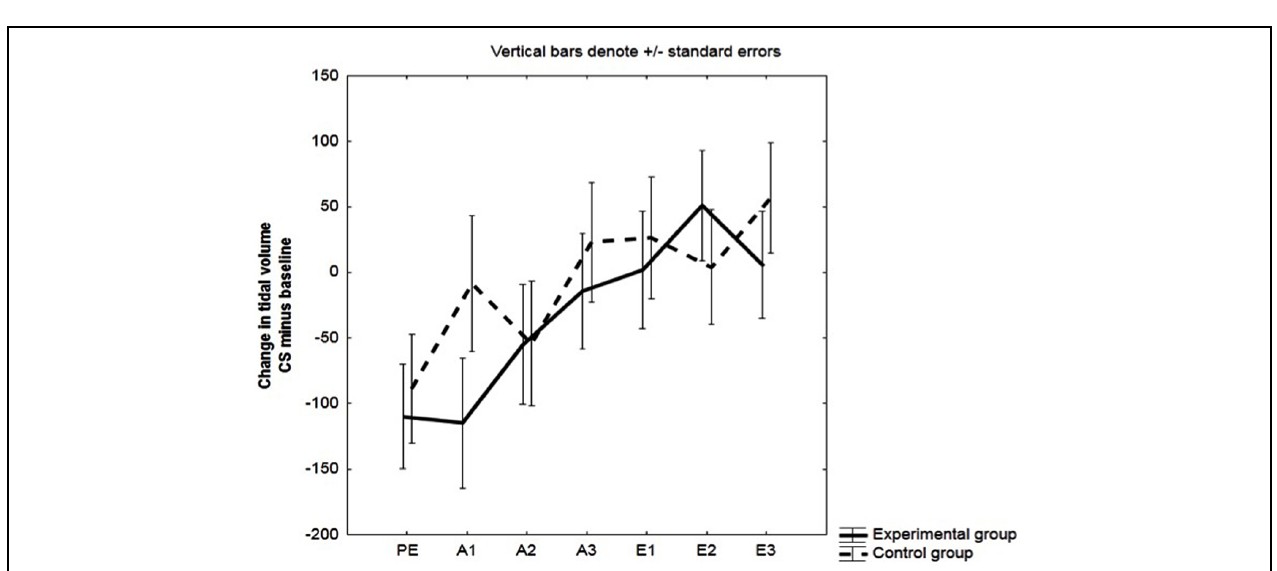
FIGURE 4 | Change in Tidal Volume (V T ). Mean changes in V T (in ml) during the CS relative to baseline (CS minus baseline) for the experimental and the control group. Respiratory responses were averaged across three pre-exposure trials (PE), two acquisition trials (A1, A2, A3), and two extinction trials (E1, E2, E3).